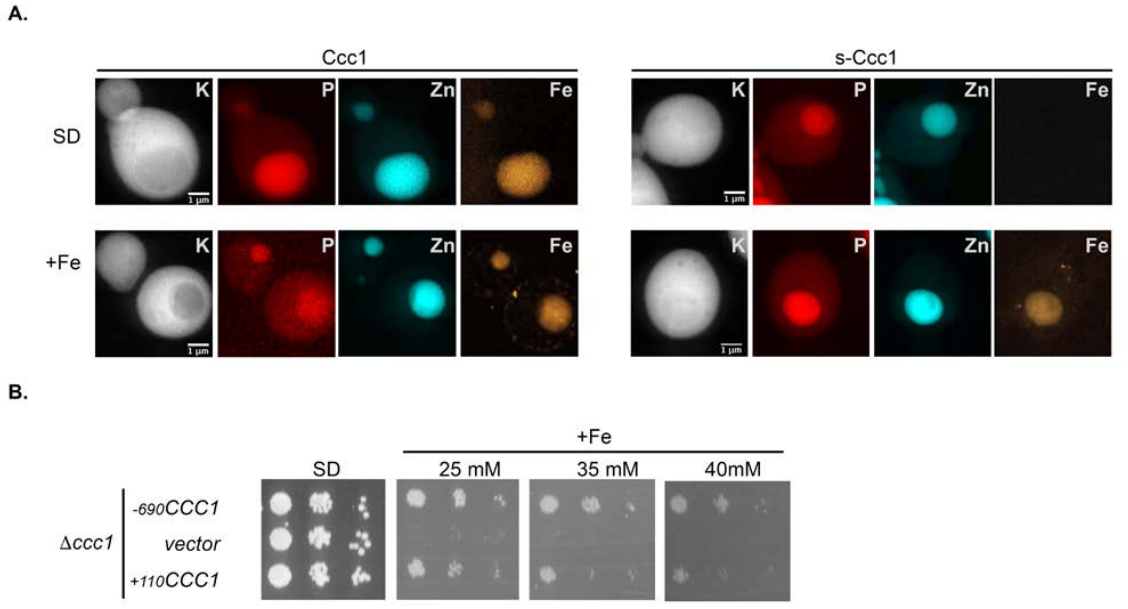
Figure 7. s-Ccc1 is not as efficient as Ccc1. ( A ) Synchrotron X-ray fluorescence nano-imaging distribution maps of potas-sium (K), phosphorus (P), zinc (Zn) and iron (Fe), in yeast cells expressing Ccc1 or s-Ccc1, under Fe replete (SD) and overload conditions (+Fe). ( B ) Exponentially growing Δ ccc1 cells transformed with the indicated plasmids or with pRS416 (vector), were serially diluted, spotted onto SD plates supplemented or not with FeSO 4 and grown for 2 days at 30 °C.